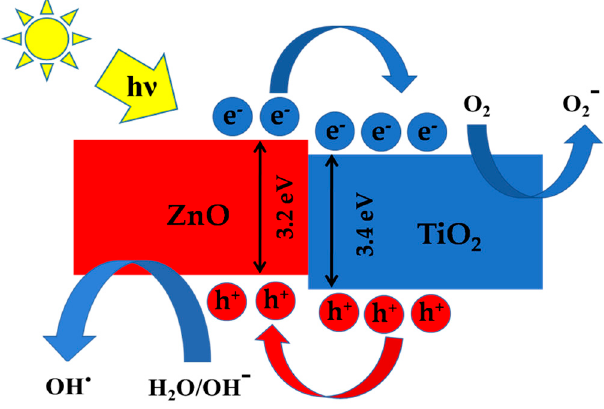
Figure 9. Illustration of photocatalytic mechanism in TiO 2 /ZnO heterojunction [46].